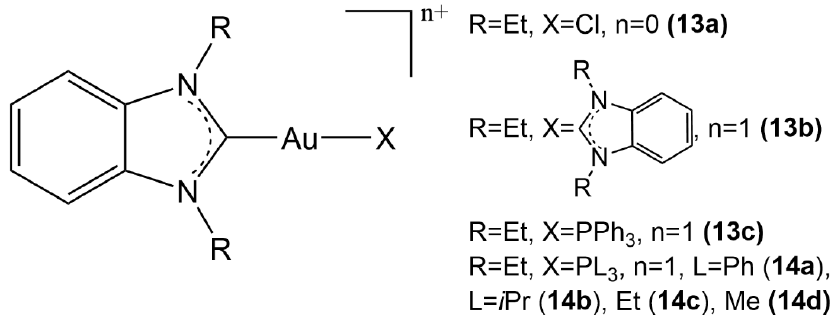
Figure 8. Gold(I) complexes with a 1,3-diethylbenzimidazol-2-ylidene N-heterocyclic carbene ( 13a – 13c , 14a – 14d ). Gold(I) NHC complexes with phosphines (Figure 8, structures 14a – 14d ) strongly